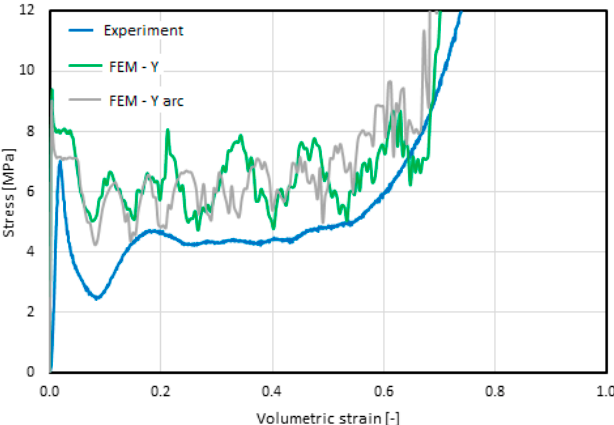
Figure 8. Maps of displacements [in mm] in the X–Y plane of the model in ( a ) the straight/idealized version; and ( b ) with the mapped shape of the rounded walls.